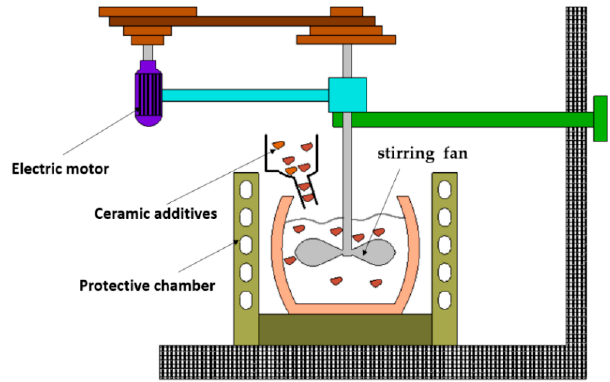
Figure 1. Stirring process with protective chamber.